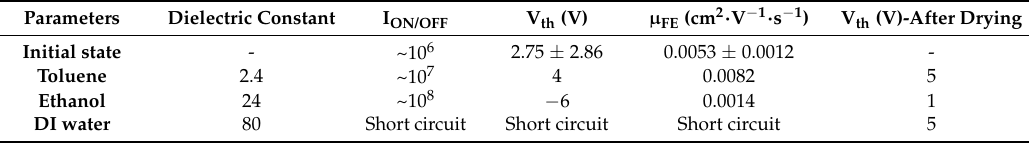
Table 1. Comparison of the electrical parameters of the ZnO-based TFT sensor under different conditions such as initial state and the various solvents on the exposed ZnO channel.